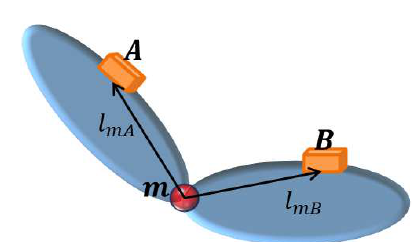
Figure 1: Illustration of the IMU position estimation problem. IMUs A and B are mounted on the adjacent segments of the joint m